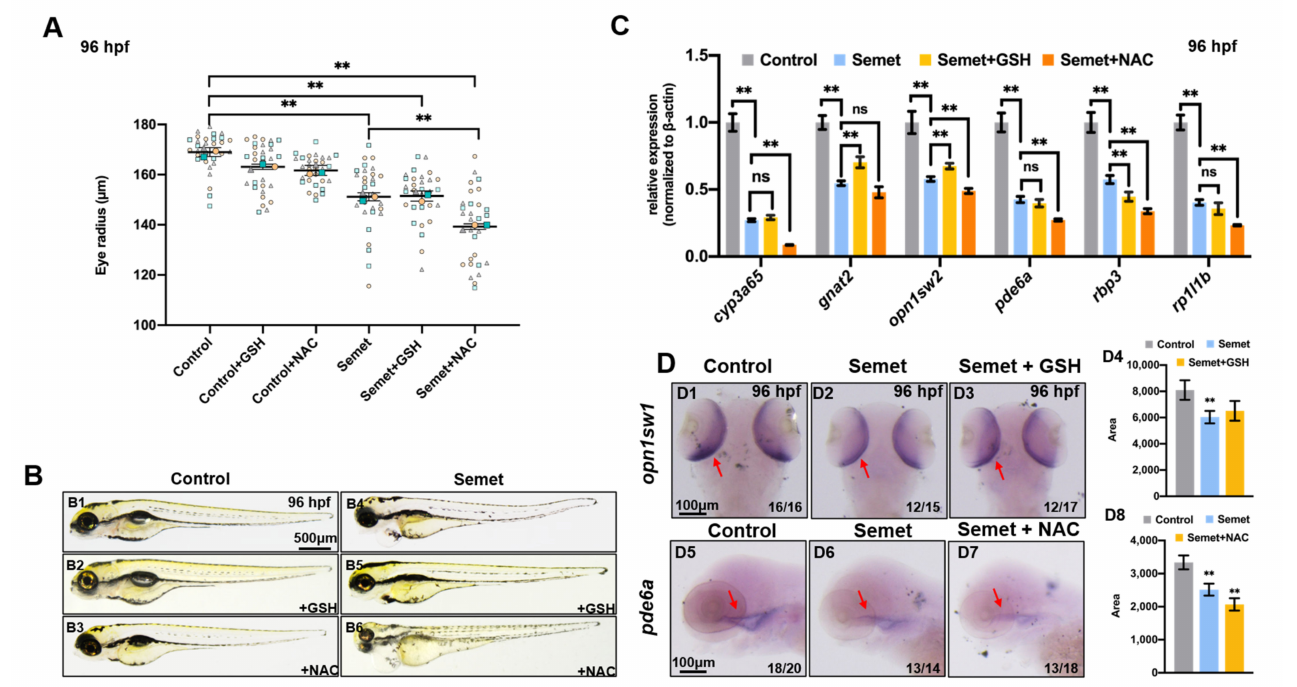
Figure 5. Effect of ocular defects with addition of ROS scavenger GSH and NAC. ( A ) Measurement of eye radius of embryos from control, semet, semet plus GSH and semet plus NAC groups at 96 hpf. ( B ) Phenotypes of representative control, semet, semet plus GSH and semet plus NAC groups at 96 hpf. ( C ) The expression of eye marker genes in control, semet, semet plus GSH and semet plus NAC groups at 96 hpf. ( D ) WISH data of opn1sw1 ( D1 – D3 ) and pde6a ( D5 – D7 ) in control, semet, semet plus GSH and semet plus NAC groups at 96 hpf. Quantification analysis of the WISH data of opn1sw1 ( D4 ) and pde6a ( D8 ) in different samples. **, P < 0.01; *, P <